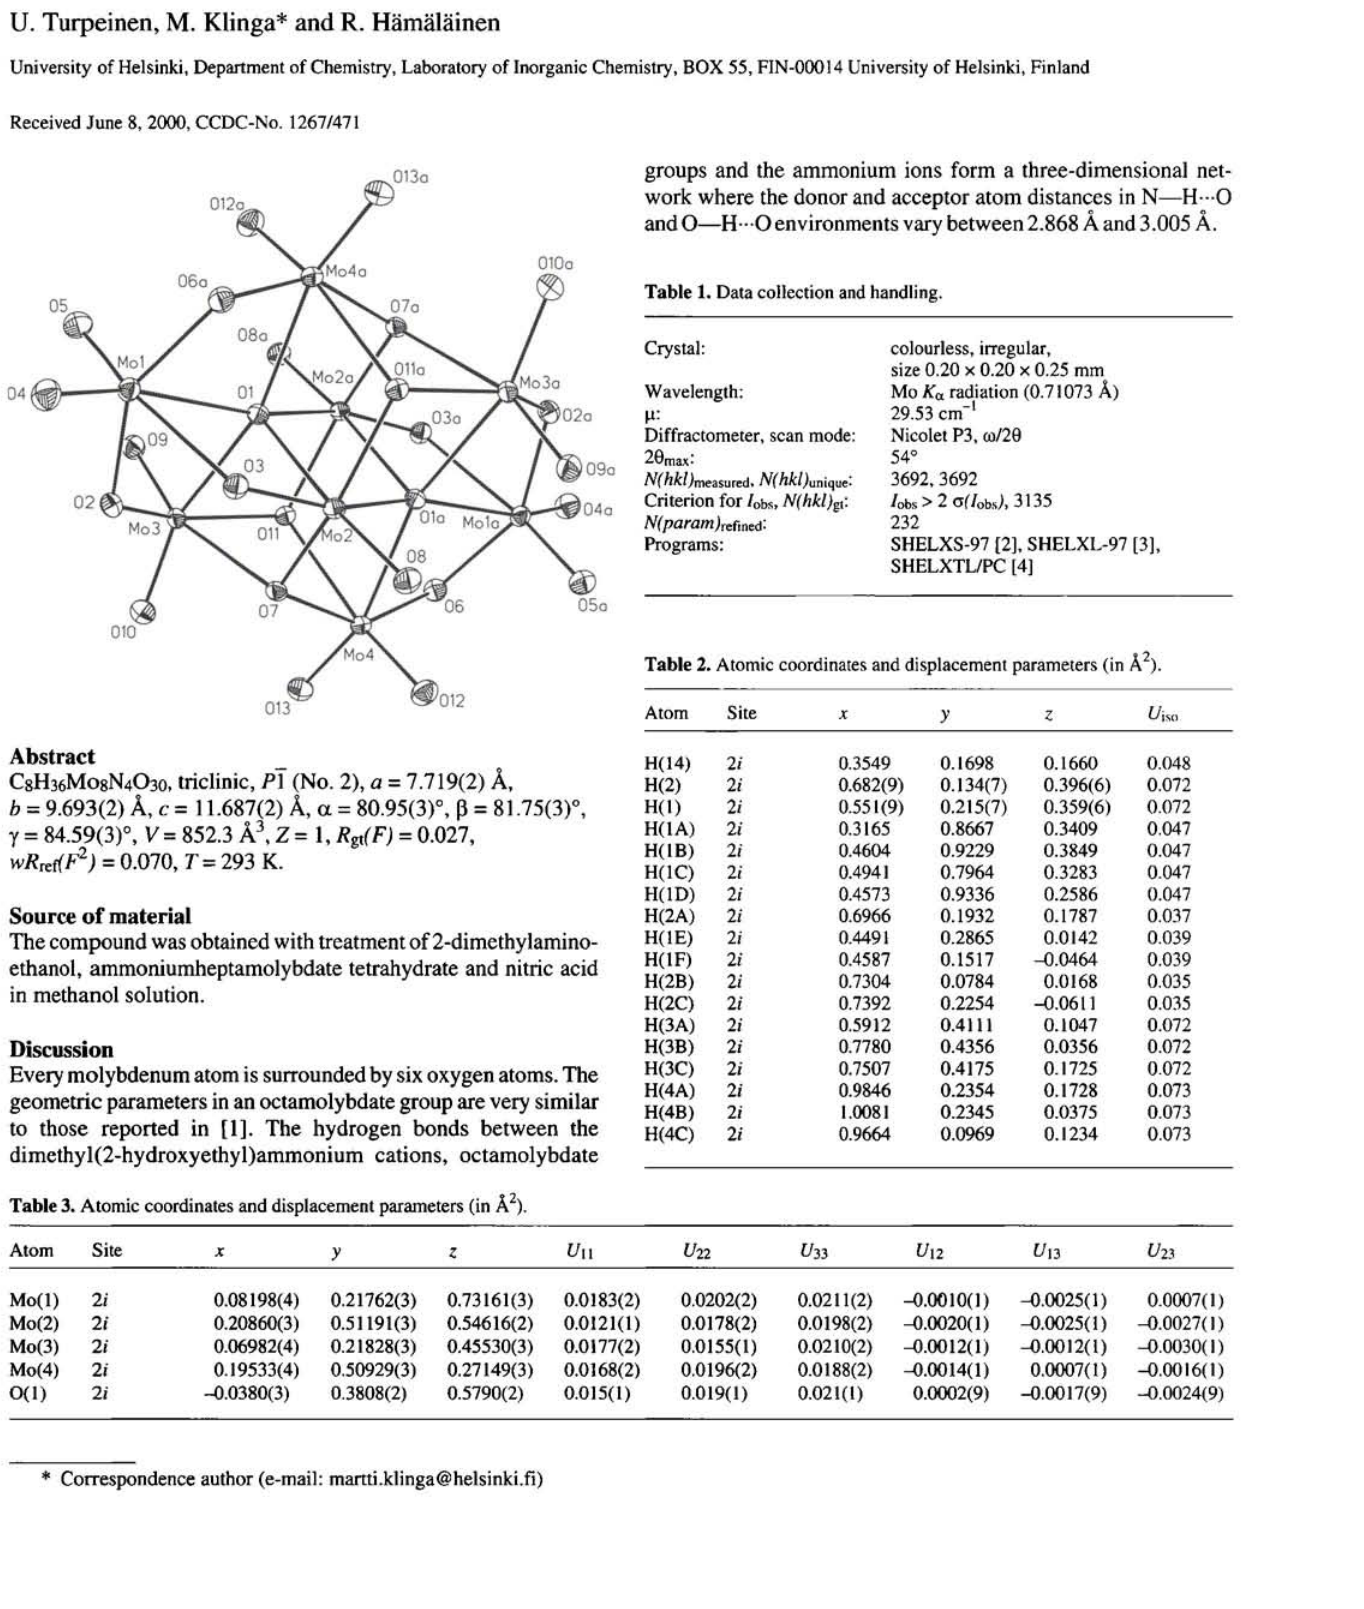
Table 1. Data collection and handling.